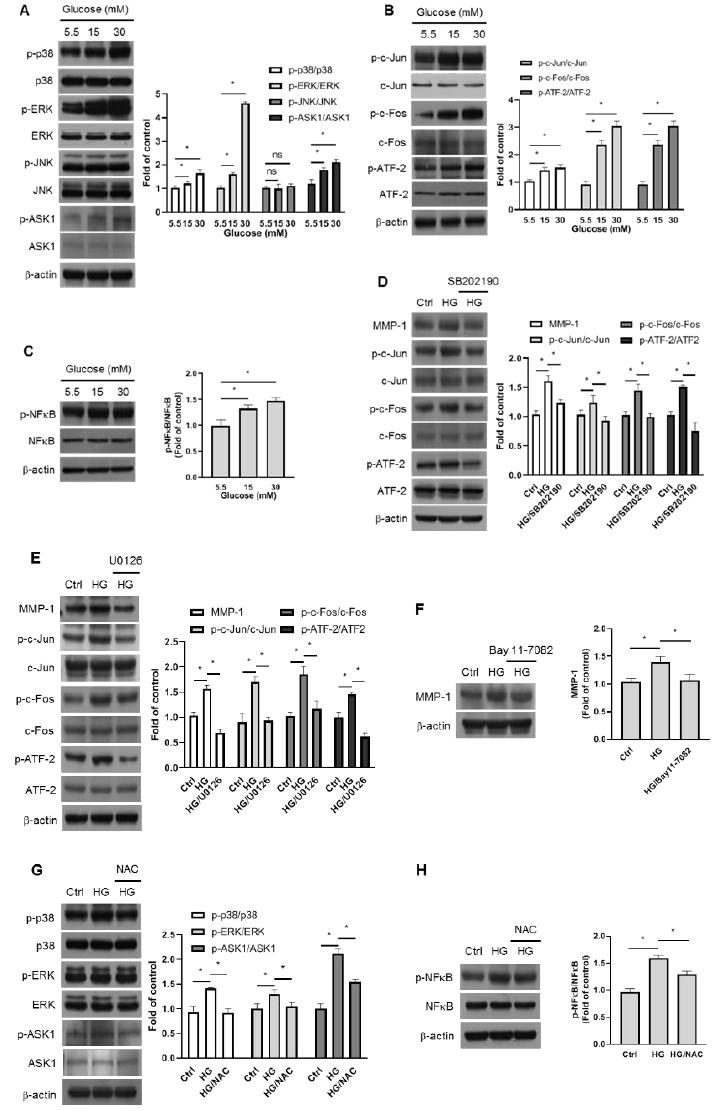
Figure 4. Suppression of p38 MAPK/ERK-mediated c-Jun/c-Fos/ATF-2 phosphorylation and NF κ B phosphorylation downregulated MMP-1 expression in high glucose-treated cells. ( A – C ) CCD- 966SK cells treated with 5.5, 15, or 30 mM of glucose for 24 h. ( Left panel ) Western blot analyses. ( Right panel ) Quantification of protein expression from Western blot analyses (* p < 0.05; NS, sta- tistically insignificant). ( A ) Western blot analyses of phosphorylated MAPKs and phosphorylated ASK1 in glucose-treated cells. ( B ) Western blot analyses of phospho-c-Jun, phospho-c-Fos, and phospho-ATF-2 in glucose-treated cells. ( C ) Western blot analyses of phospho-NF κ B in glucose- treated cells. ( D – H ) CCD- 966SK cells were pretreated with 10 μM SB202190 or U0126 or 5 μM Bay11 - 7082 or 5 mM NAC for 1 h and then incubated with 30 mM glucose for 24 h. ( Left panel ) Western blot analyses. ( Right panel ) Quantification of protein expression from Western blot analyses (* p < 0.05; NS, statistically insignificant). Effect of SB202190 ( D ) or U0126 ( E ) on MMP-1, phospho-c-Jun, phospho-c-Fos, and phospho-ATF-2 protein expression in high glucose-treated cells. ( F ) Effect of Bay11-7082 on MMP-1 protein expression in high glucose-treated cells. ( G ) Effect of NAC on the levels of phosphorylated MPAKs and phosphorylated ASK1 in high glucose-treated cells. ( H ) Effect of NAC on the levels of phospho-NF κ B in high glucose-treated cells.